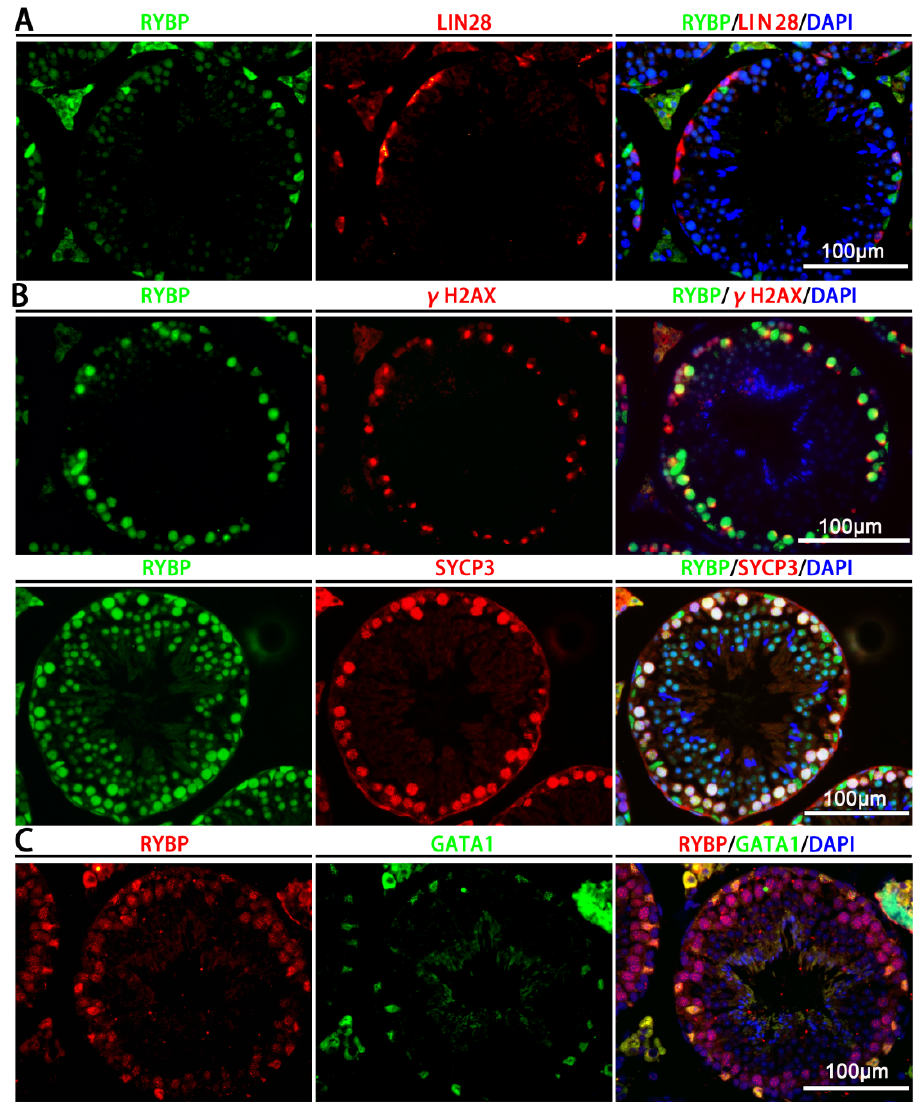
Figure 2. Rybp expressed in spermatocytes and Sertoli cells. ( A ) Coimmunofluorescent staining for Rybp and LIN28A in cross-sections of testes from adult mice. Scale bar, 100 μm. ( B ) Immunofluorescent staining for Rybp, γH2AX, and synaptonemal complex protein 3 (SYCP3) in cross-sections of testes from adult mice. Scale bar, 100 μm. ( C ) Immunofluorescent staining for Rybp and GATA1 (Sertoli cell marker) in cross-sections of testes from adult mice. Scale bar, 100 μm.